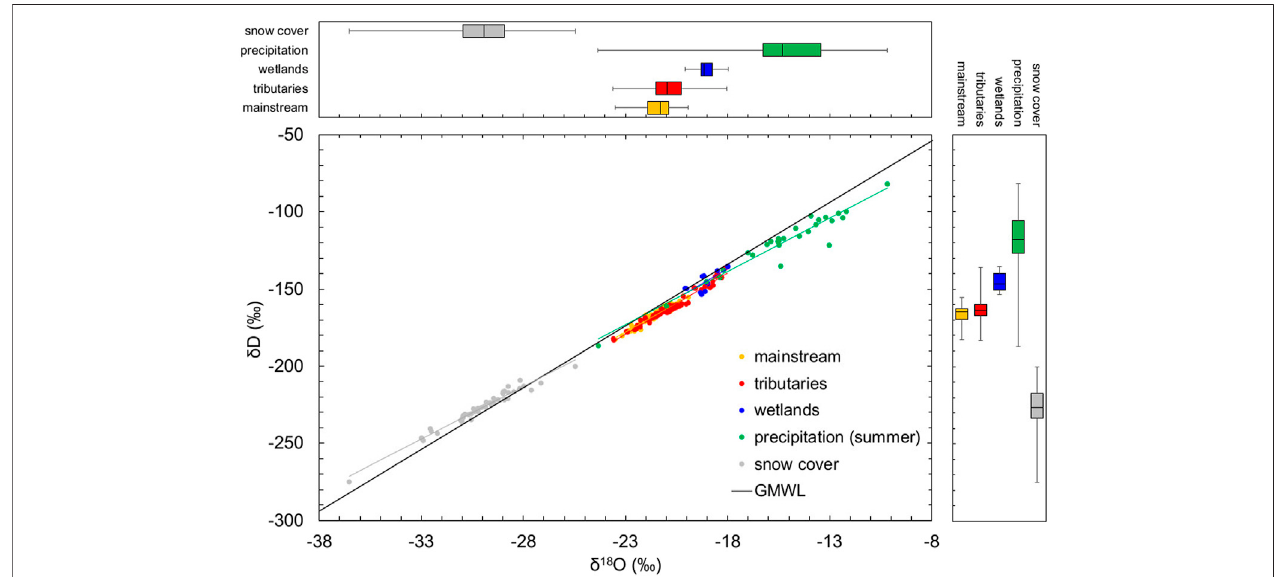
FIGURE 2 | δ D − δ 18 O plot grouping Indigirka mainstream and tributaries, wetlands, precipitation in summer, and snow cover with different colors and showing distributionsasboxplotsonthetopandsidepanels.TheGlobalMeteoricWaterLine(GMWL; δ D (cid:2) 8 × δ 18 O+10)isshownasablacksolidline.Thesedatawereobtained during summer in 2010 – 2014, and the data of snow cover were obtained in April 2014. The isotopic compositions of Indigirka mainstream and tributaries in 2011 and 2012, summer precipitation in 2012 – 2014, and snow cover are cited from Takano et al. (2019).